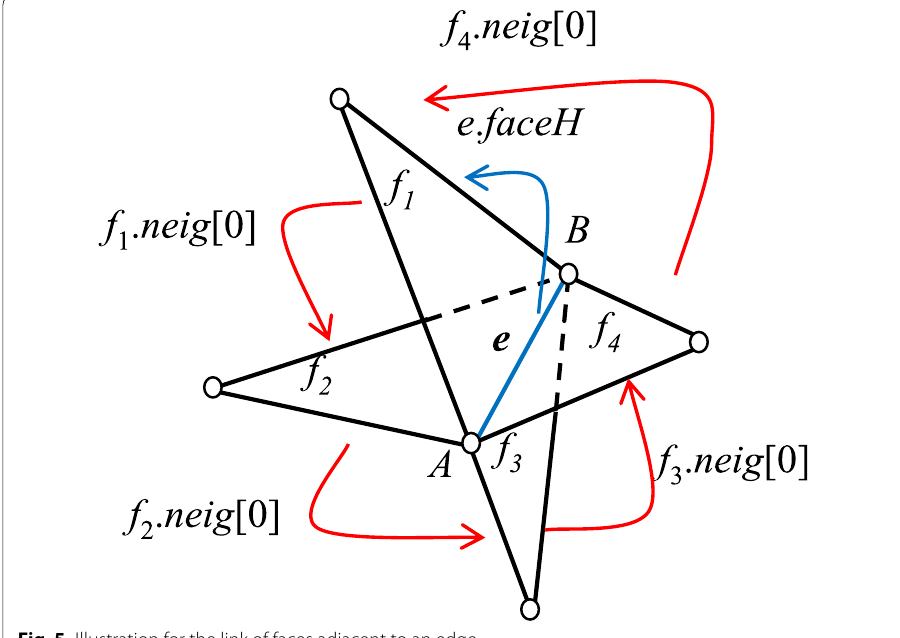
Fig. 5 Illustration for the link of faces adjacent to an